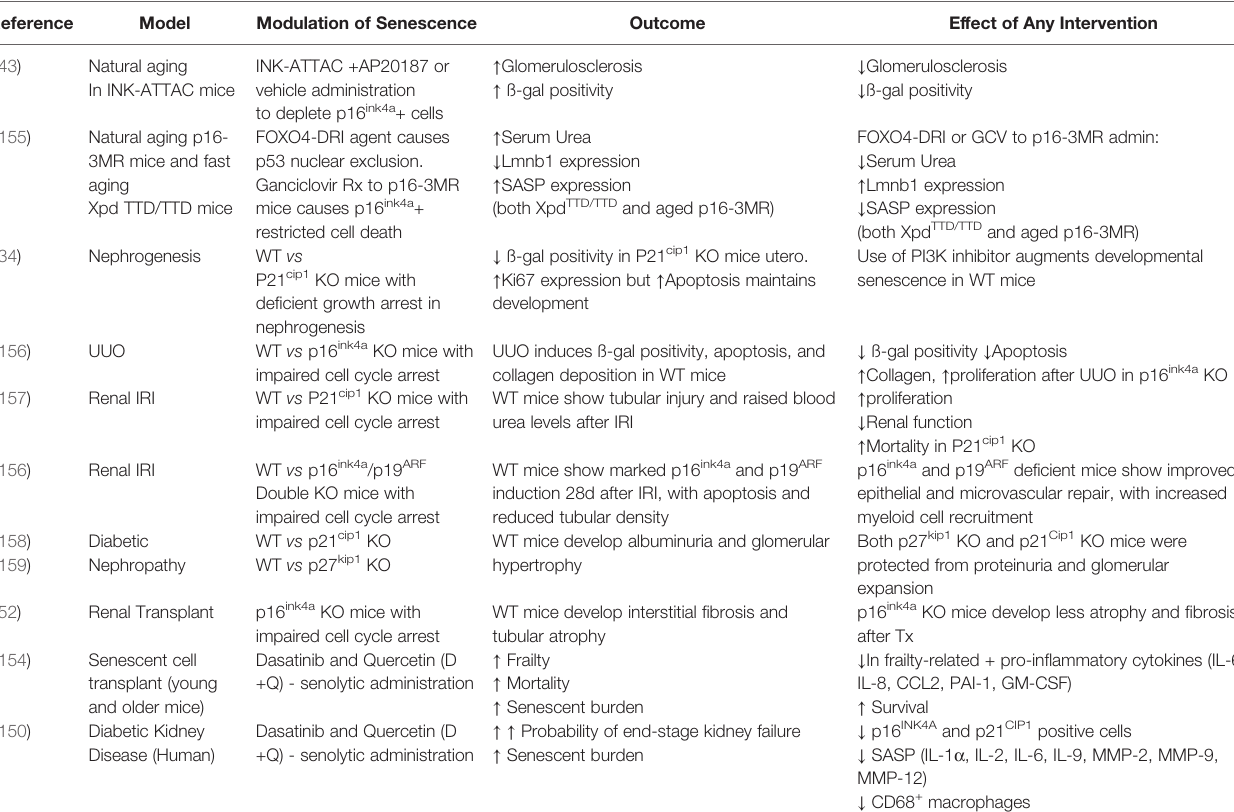
TABLE 1 | Experimental models of senescent cell de fi ciency/induction/depletion in the kidney and their effects on renal